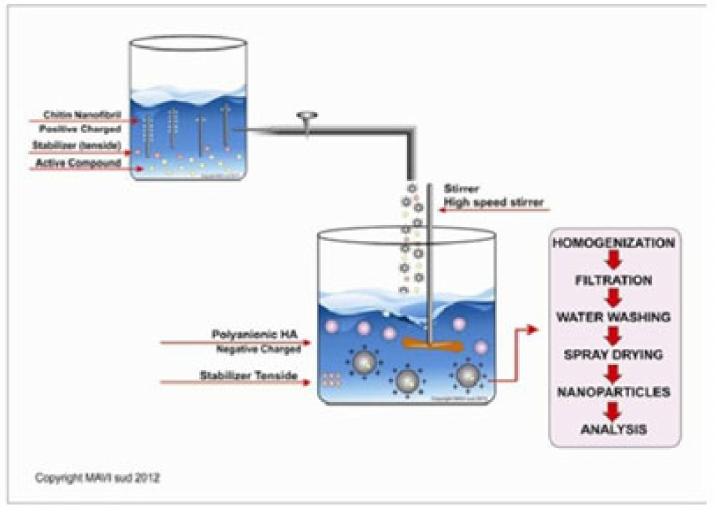
Figure 5. The complex chitin–lignin obtained by the gelation